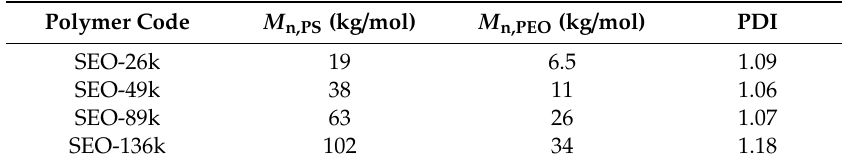
Table 1. Name codes, number average molecular weights ( M n ) and the polydispersity index (PDI)